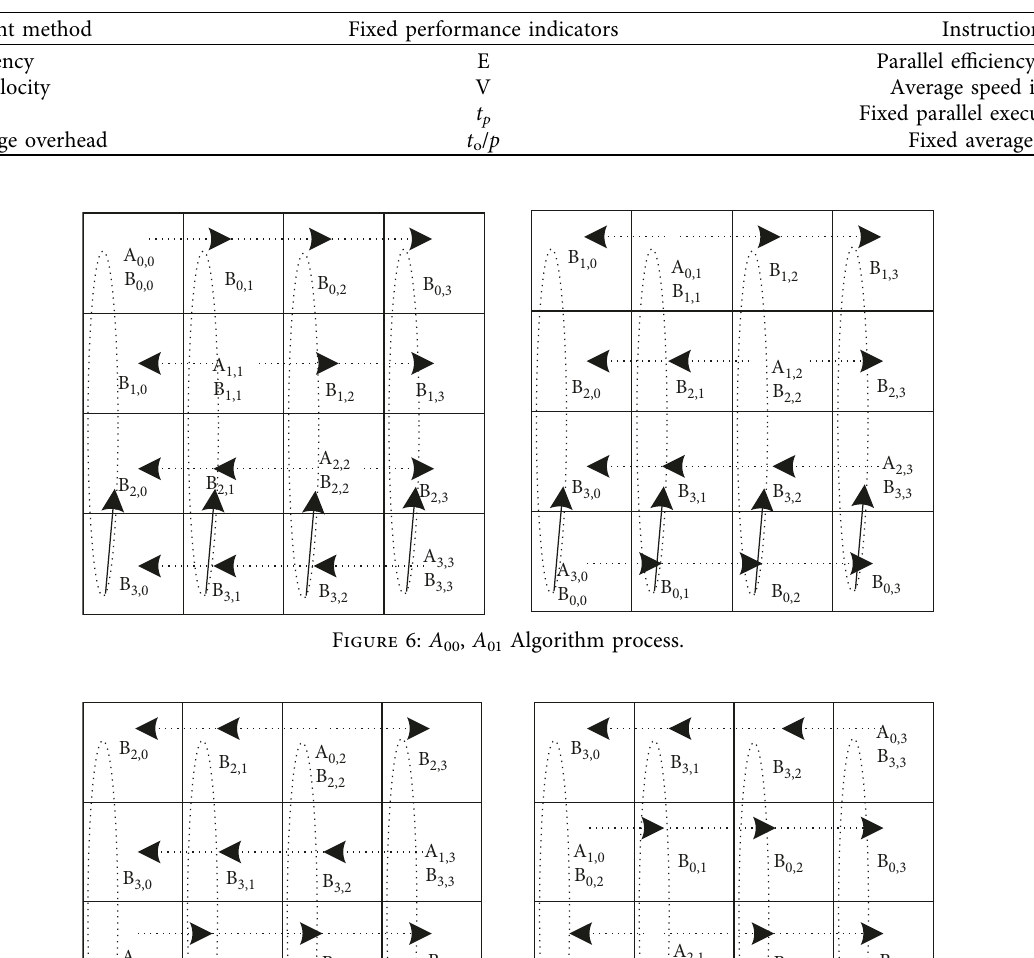
Table 3: Measurement method of the performance-fixed scalable